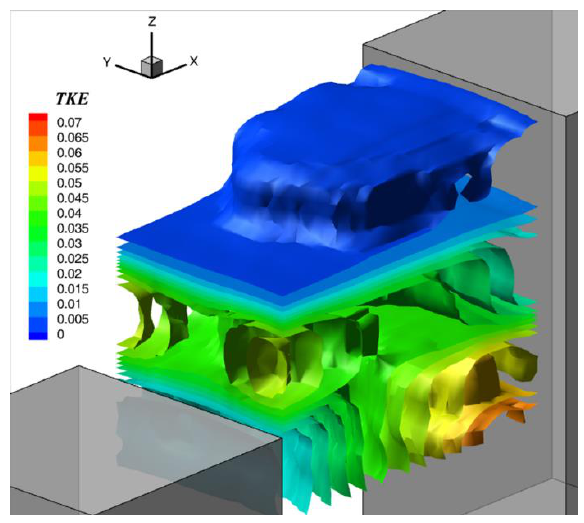
Fig. 8. Isosurfaces of Turbulent Kinetic Energy in the whole measurement domain .